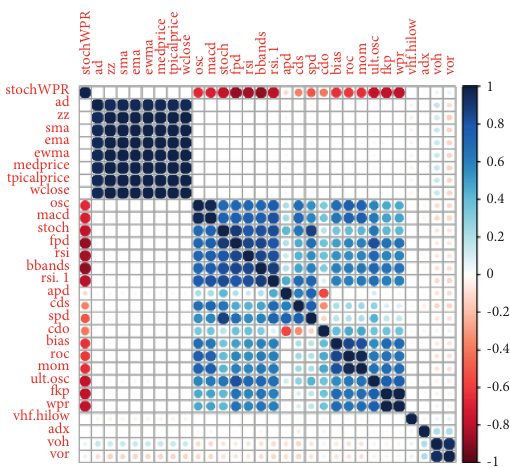
Figure 5: Highly correlated matrix for 32